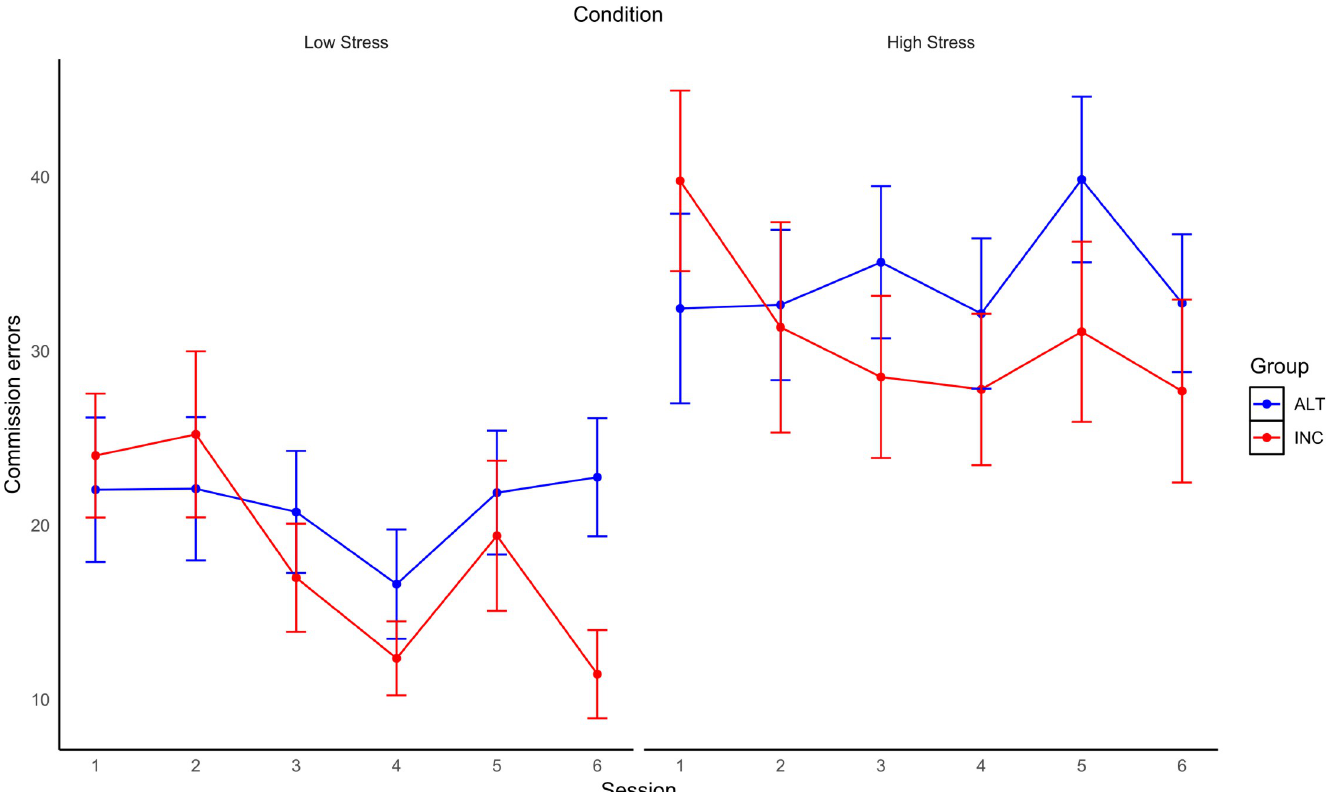
Fig 8. Changes in errors of commission across sessions in low and high time-stress conditions for each group. Percentage errors of commission over Sessions in the Low (left) and High (right) time-stress conditions for each Group (error bars are SE).